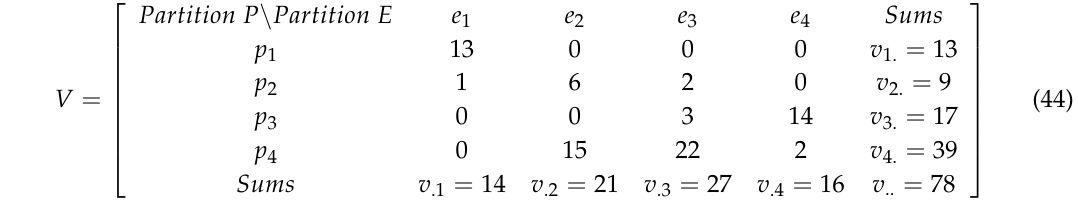
Figure 10. Distribution of the technological mining cuts; ( a ) for the (78 × 4) input data matrix—four criteria; ( b ) for the (78 × 6) input data matrix—six criteria.